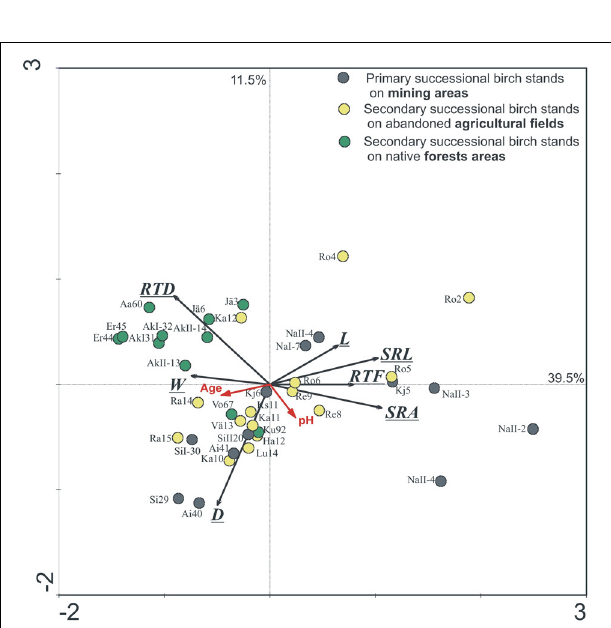
FIGURE 2 | The Estonian birch stands on the ordination plot based on redundancy analyses of EcM root tip morphological parameters [SRL, SRA, root tissue density (RTD), diameter (D), length (L), mass (M), and root tip frequency per mass unit (RTF, No/mg)]. Numbers after label show the age of the stand. The sites and stand age account for 56.2% of total variability. Axis 1 describes 39.5% and axis 2 describes 11.5% of the total morphological variation, p = 0 . 001. Abbreviations of sites are shown in Supplementary Table